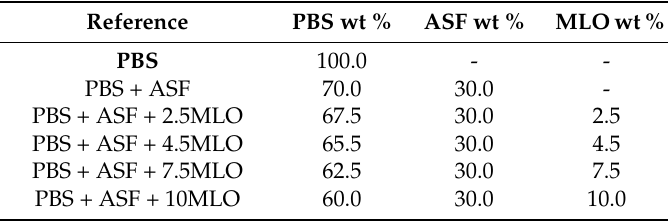
Table 1. Composition and labelling of poly(butylene succinate) composites with almond shell flour (ASF) and different maleinized linseed oil (MLO) compatibilizing